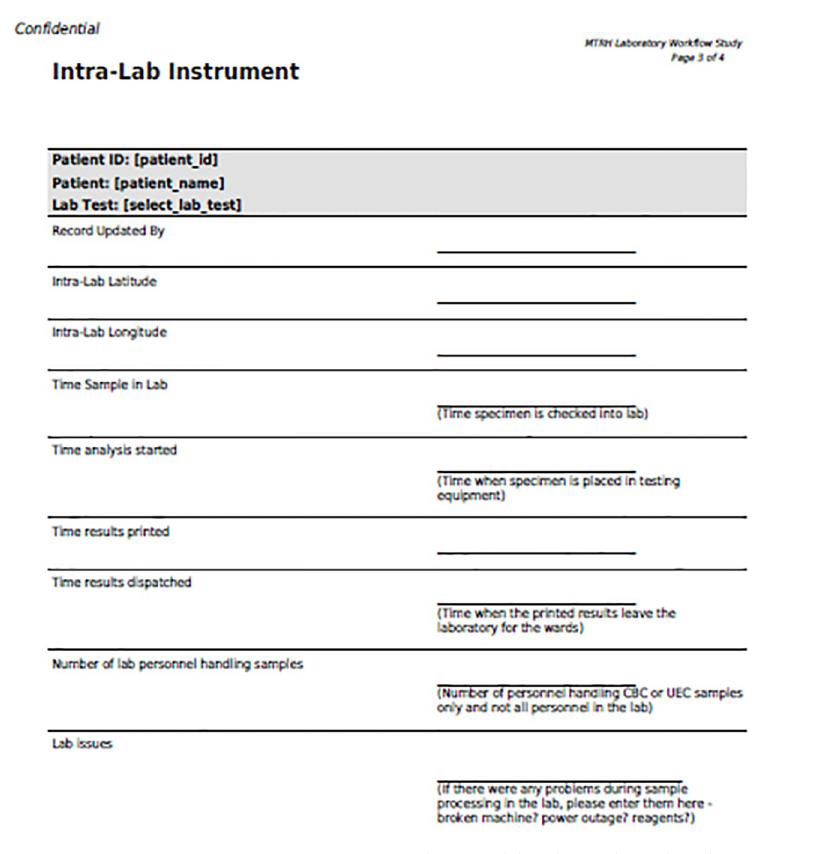
Fig 9. Intra laboratory instrument. Instrument used to record data during the analytical stage.